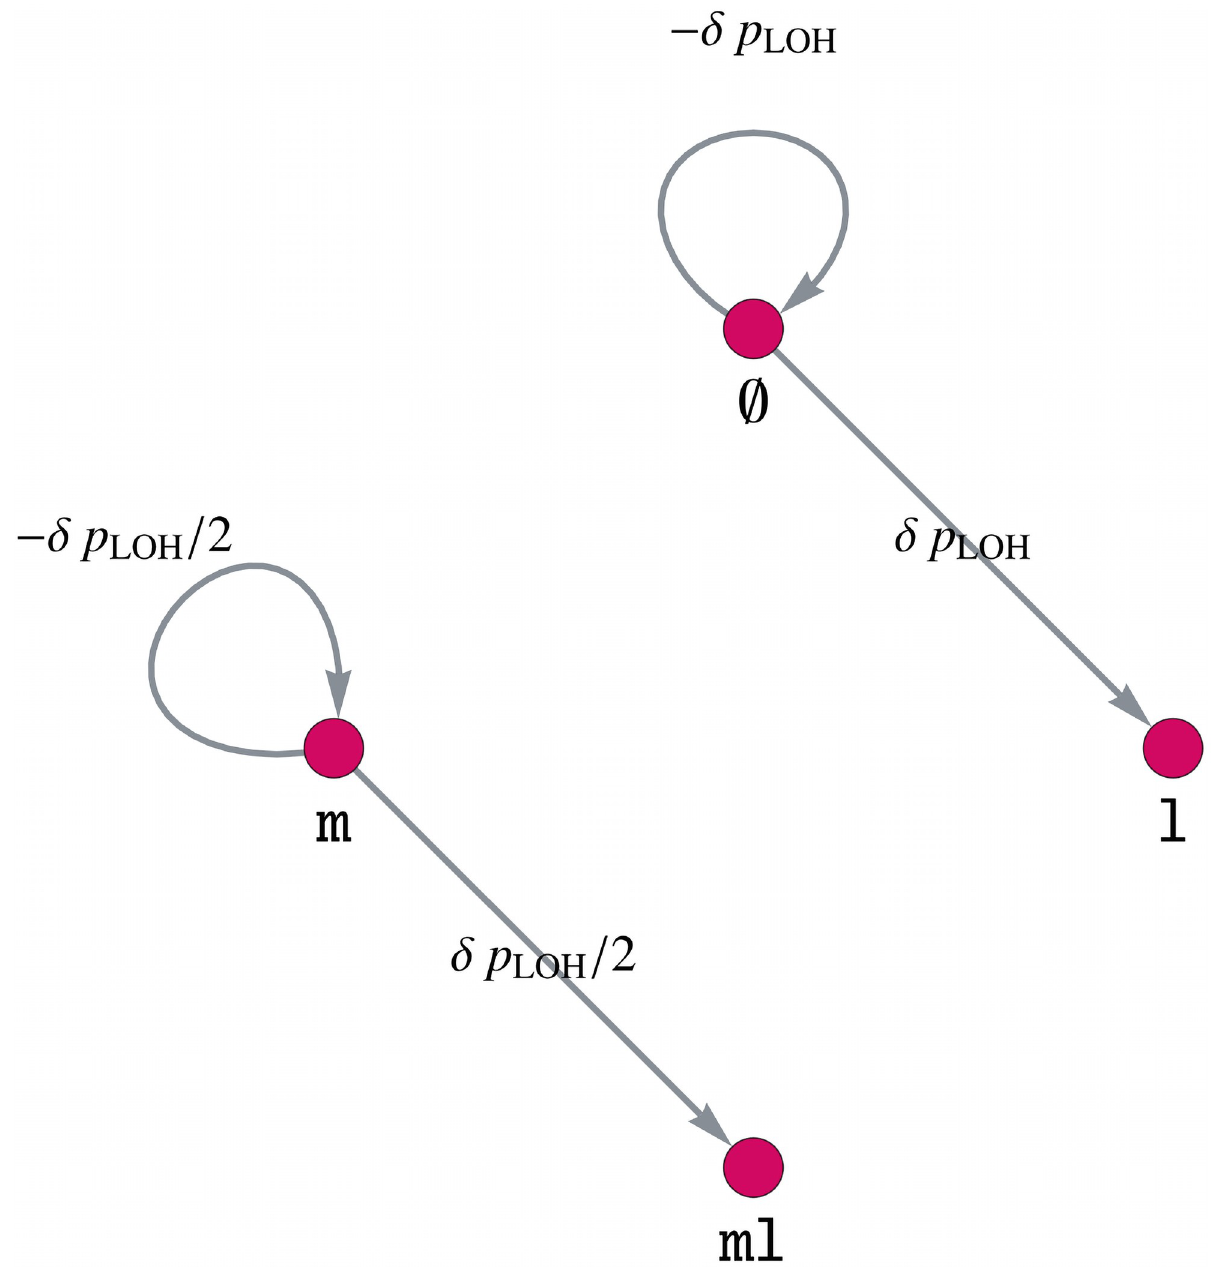
Fig 6. Model component for increasing the LOH rate of MMR, CTNNB1 and TP53 by a factor δ + 1 after APC inactivation. Gene mutation graph for both genes, CTNNB1 and TP53 , of the component D . The gene mutation graph for MMR is defined in an analogous way.